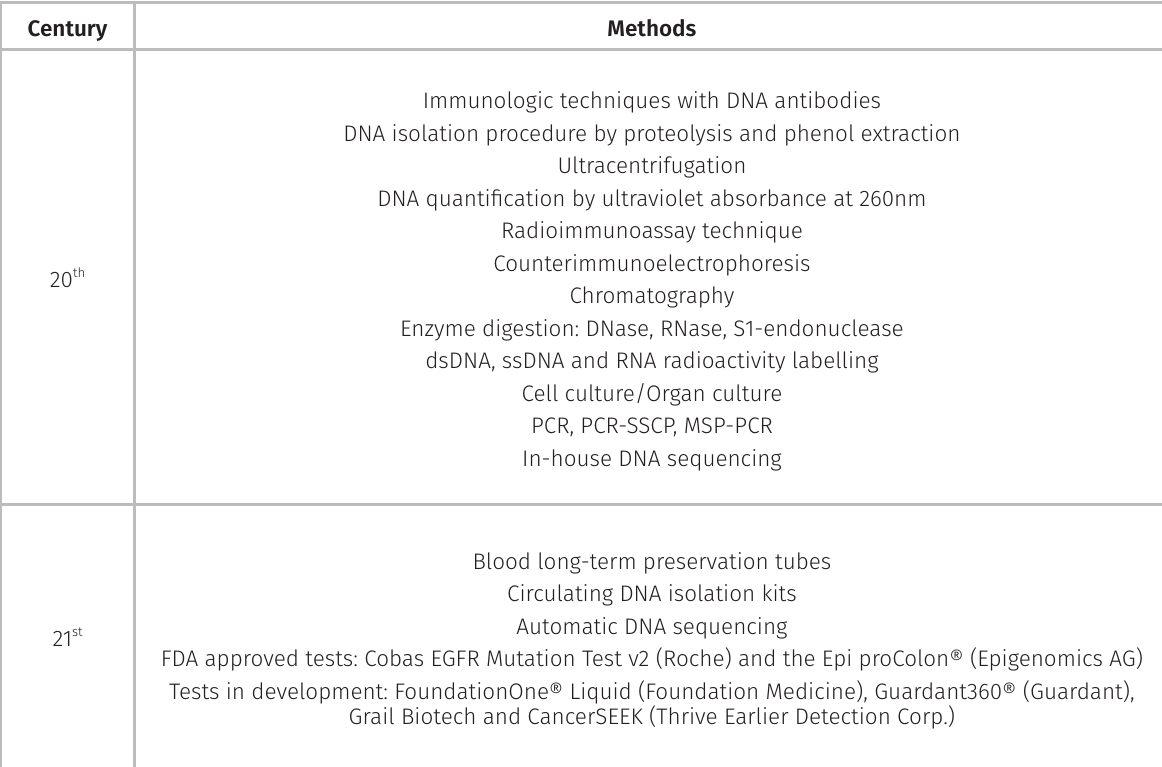
Enzyme digestion: DNase, RNase, S1-endonuclease dsDNA, ssDNA and RNA radioactivity